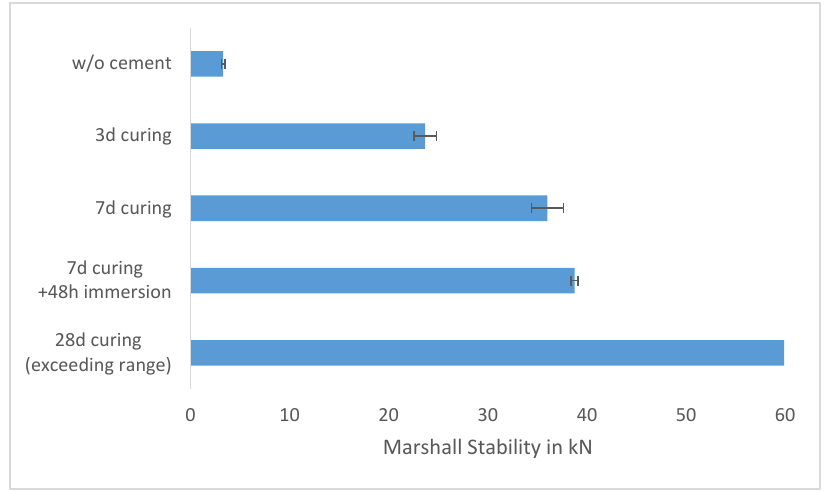
Figure 4. Marshall stability test results at different curing times.